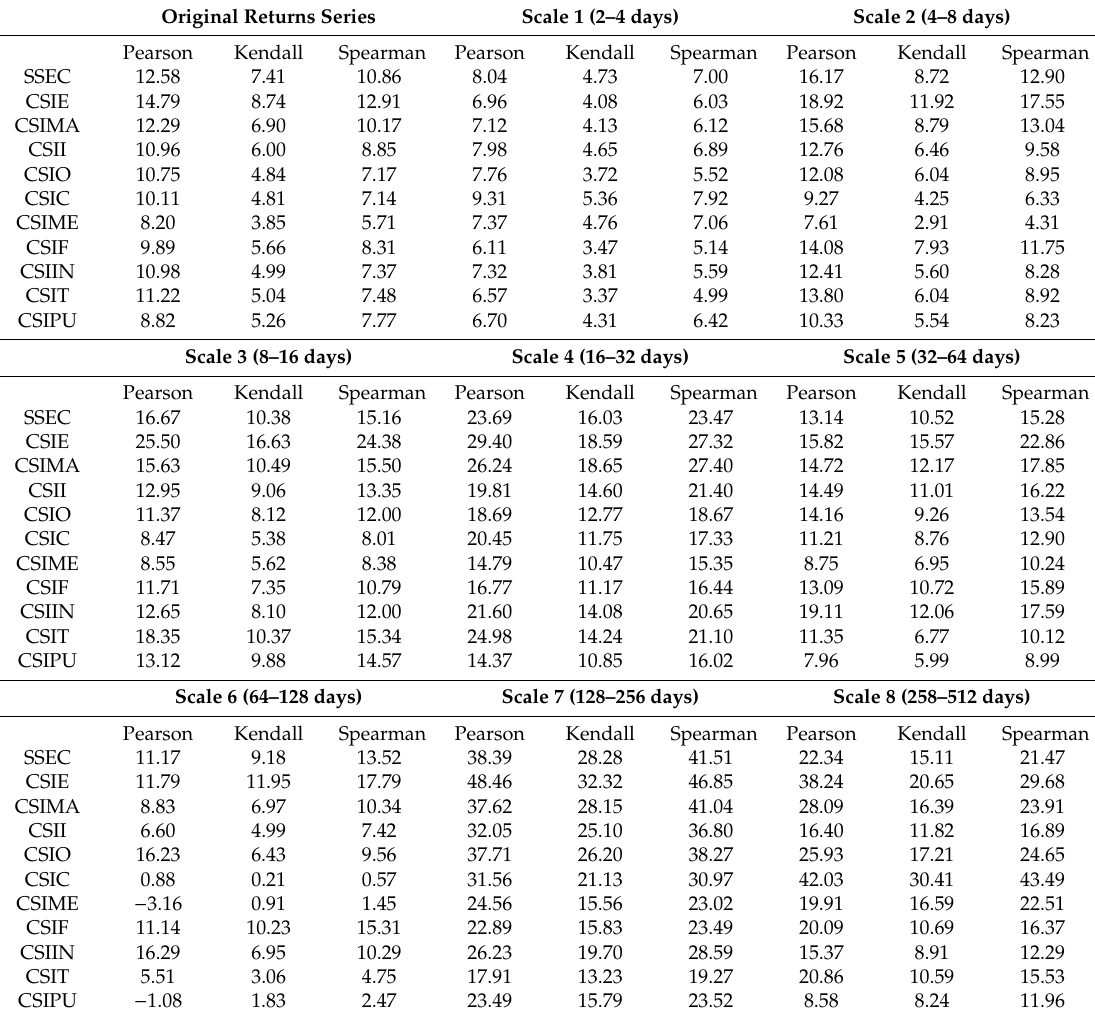
Table 2. Multi-scale correlation analysis between with Brent spot price and the stock indexes. Original Returns Series